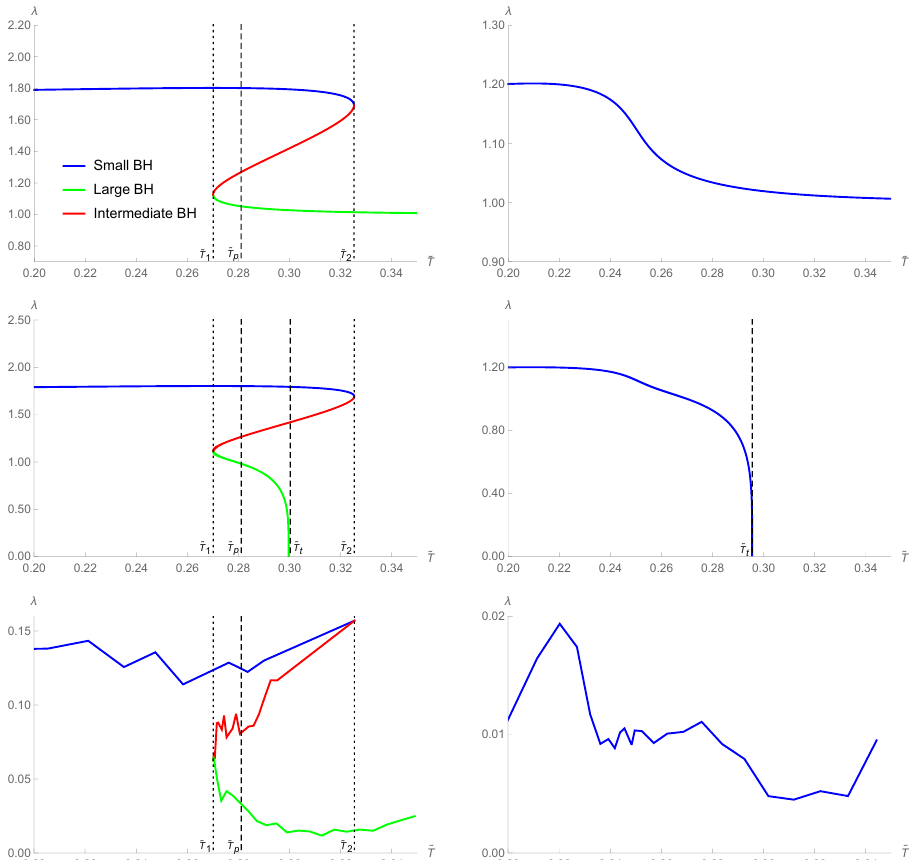
Figure 3 . Lyapunov exponents λ of particles and strings as a function of the temperature ˜ T for ˜ Q = 0 . 11 < ˜ Q ˜ Q = 0 . 20 > ˜ Q c ( Left Column ) and c ( Right Column ). Top Row : Massless particles on the unstable null circular geodesic; Middle Row : Massive particles with L = 20 l on the unstable time-like circular geodesic; Bottom row : Motion of ring strings with the initial conditions θ 0 = 0 , E = 1000 , d ( r cos θ ) = 0 and r 0 = 5 . 92 ( Left ) and 7 . 30 ( Right ). Three black hole solutions, i.e., dτ Small BH, Intermediate BH and Large BH, coexist for ˜ T 1 < ˜ T < ˜ T 2 . The phase transition between Small BH and Large BH occurs at ˜ T = ˜ T p , and λ of massive particles vanishes at ˜ T = ˜ T t . When ˜ Q < ˜ Q ˜ T with three branches, which coincide with the three black c , λ is a multivalued function of hole solutions, respectively. When ˜ Q > ˜ Q c , λ is single-valued, demonstrating that there is only one black hole solution. These observations imply that λ as a function of ˜ T can reflect the phase structure of RN-AdS black